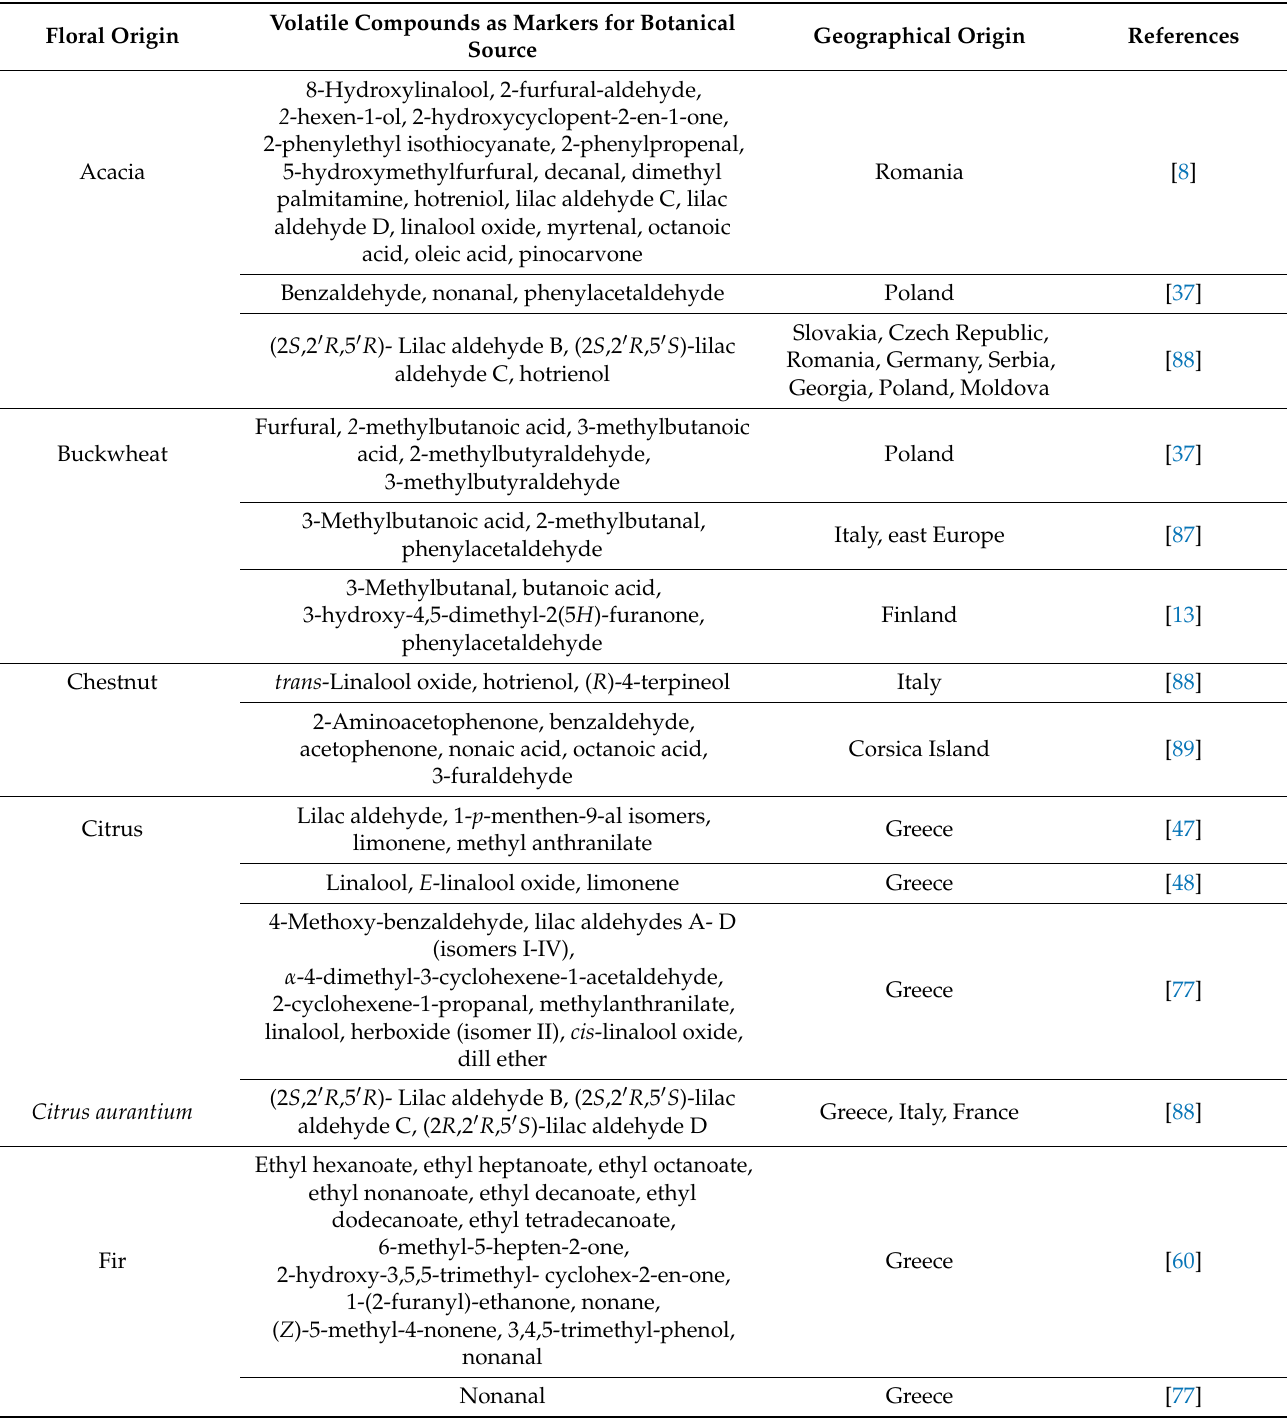
Table 1. Employment of SPME-GC-MS technique for the determination of volatile compounds for botanical characterization of unifloral